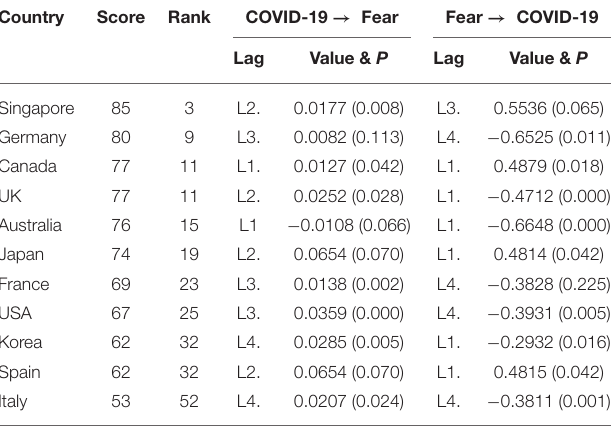
TABLE 7 | Country-based robustness